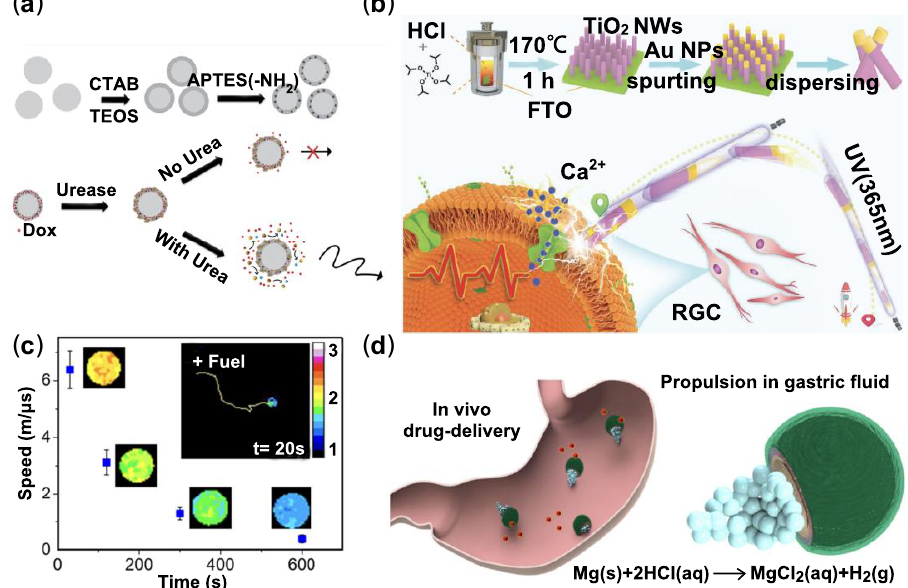
Figure 7. Schematic illustration of chemical-induced propulsion in biomedical application. ( a ) Schematic diagram of the fabrication process and some features of urease-powered nanorobots [173] (Reproduced with permission from Hortelão et al., Advanced Functional Materials; published by Wiley, 2018); ( b ) Method of the assemblage of TiO 2 -Au NW and the photoelectric conversion capability of the particle to activate and regulate the neuron cell [175] (Reproduced with permission from de Á vila et al., Nature Communication; published by Springer Nature, 2017); ( c ) Correlation between propulsion speed of the mesoporous silica-based micromotors with a nanoswitch and pH of the surroundings [176] (Reproduced with permission from Patino et al., Nano Letters; published by American Chemical Society, 2019); ( d ) Image of propulsion mechanism and drug delivery of mag- nesium micromotors in the mouse stomach [177] (Reproduced with permission from Peng et al., Advanced Functional Materials; published by Wiley, 2017).